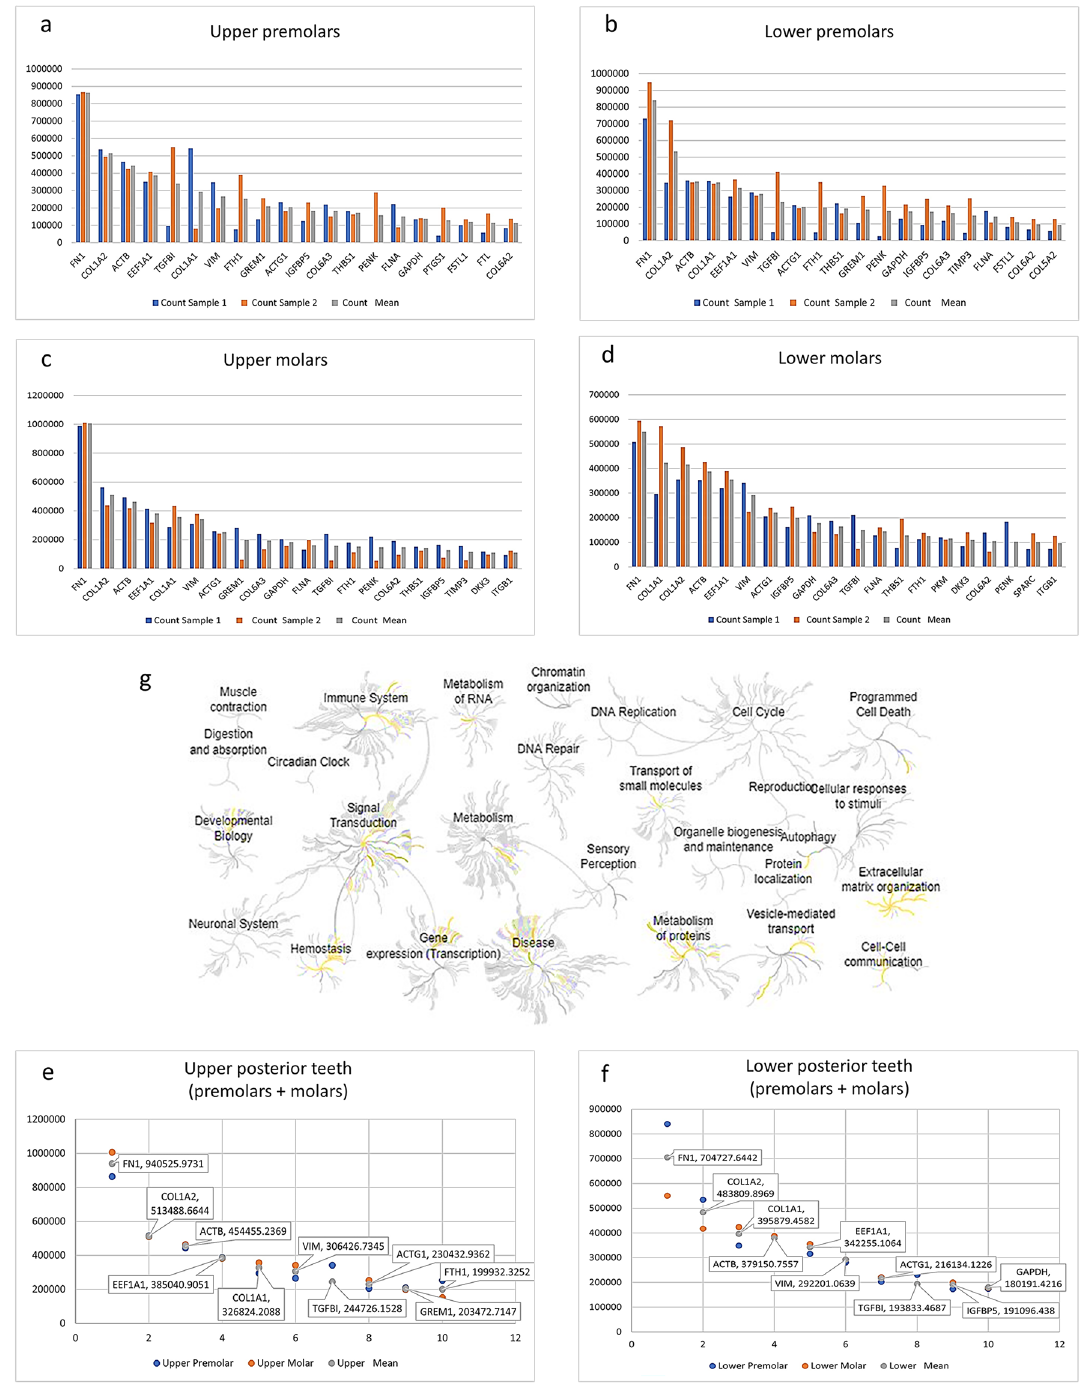
Figure 1. Top expression genes and related pathways. ( a – d ) Bar plots demonstrating the top 20 genes with the highest expression levels in the upper premolars ( a ), lower premolars ( b ), upper molars ( c ), and lower molars ( d ). ( e ) The reactome diagram presents the related pathways (in yellow) with the common 15 genes ( ACTB, COL1A1, COL1A2, COL6A2, COL6A3, EEF1A1, FLNA, FN1, FTH1, GAPDH, IGFBP5, PENK, TGFB1, THBS1, and VIM ) that were found in the upper premolars, lower premolars, upper molars, and lower molars. ( f , g ) Dot plots indicating the top ten most expressed genes in the upper posterior teeth ( e ) and lower posterior teeth ( f